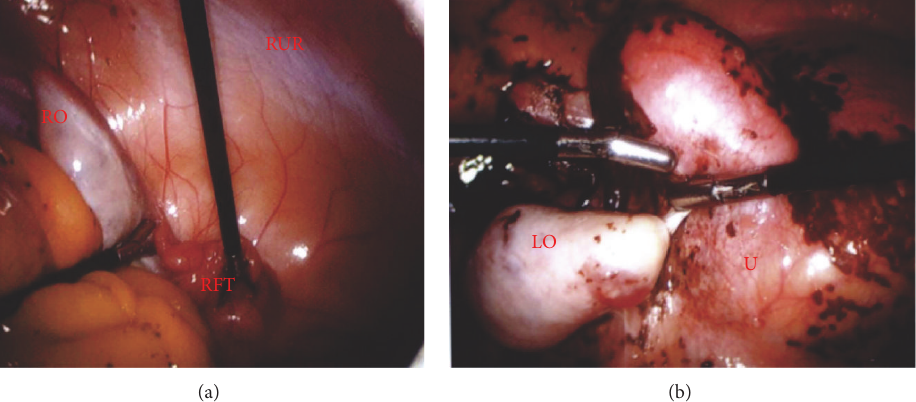
Figure 2: Laparoscopy of the pelvis. (a) Right fallopian tube (RFT), right ovary (RO), and a right uterine remnant (RUR). (b) Left ovary (LO) and distended uterus (U) with hemosiderin (brown).